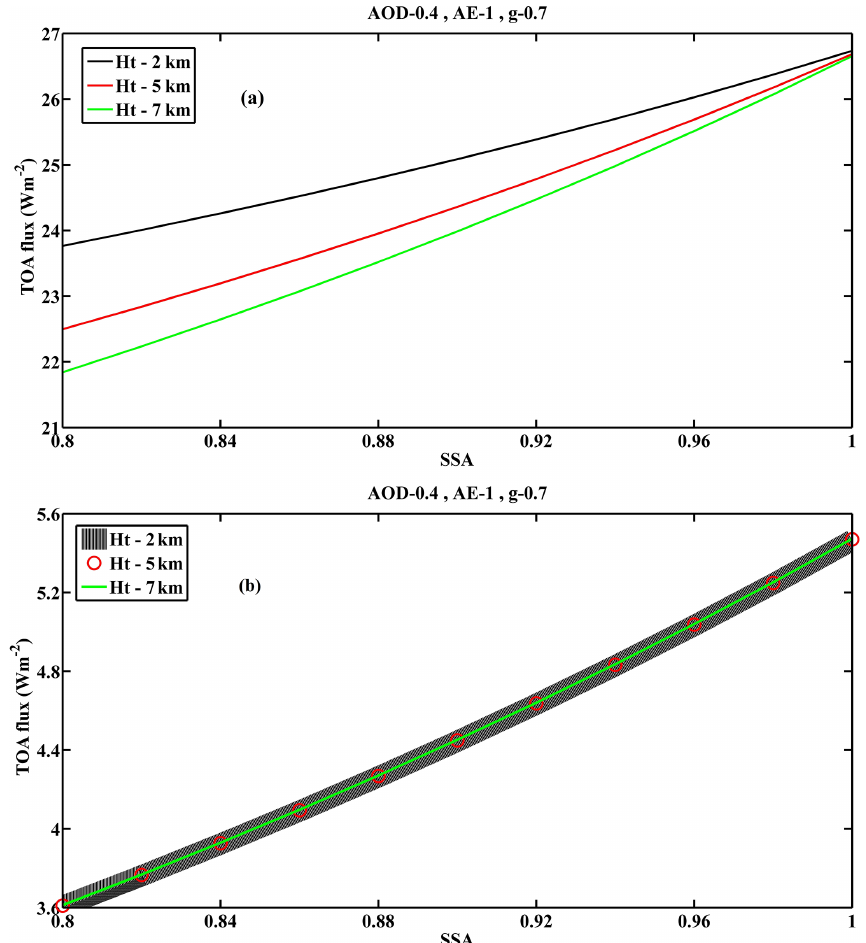
Figure 7. TOA flux calculated from SBDART for different SSAs and ALHs (a) with Rayleigh scattering and (b) without Rayleigh scattering for UV wavelengths between 300 and 400nm). Here “Ht” represents the ALH in